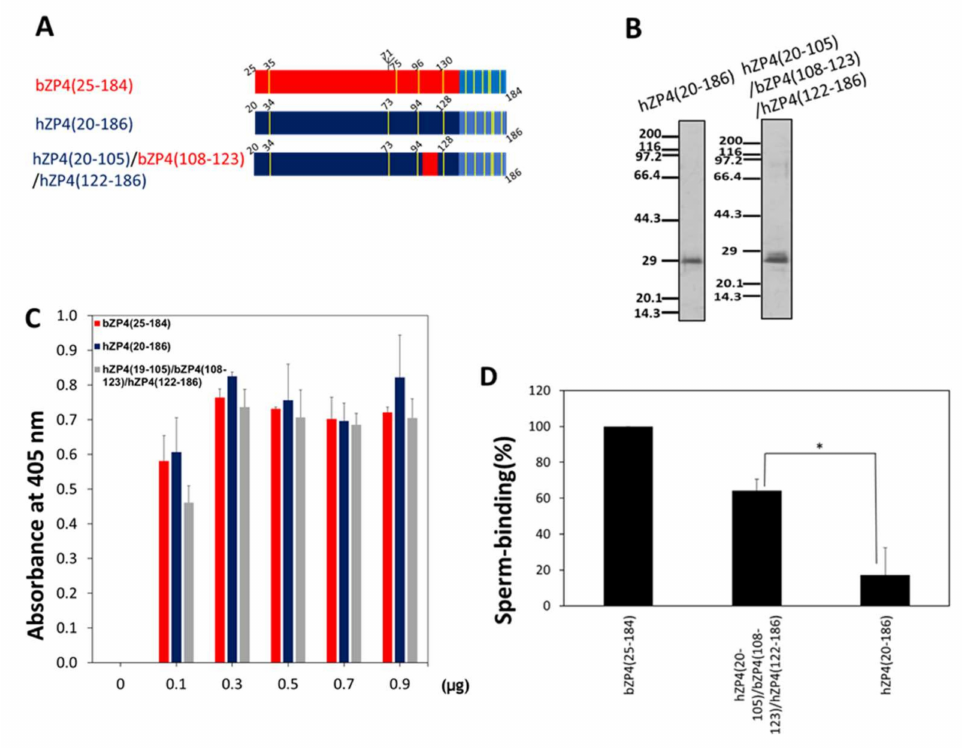
Figure 5. Sperm-binding activity of the sperm-binding site in the C-terminal half of the ZP-N1 domain of bZP4 in the framework of human ZP4. ( A ) Schematic of the truncated bZP4(25–184) (red), its corresponding human (h)ZP4(20–186) counterpart (dark blue) and the chimeric protein in